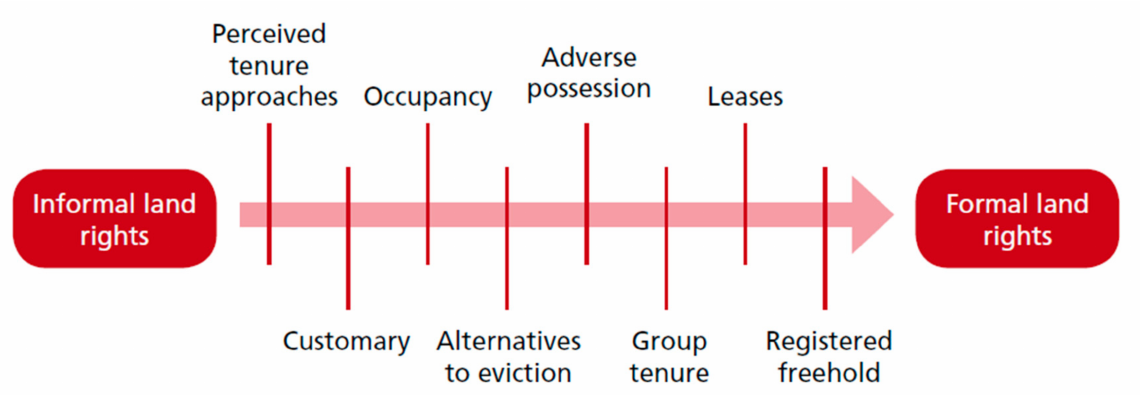
Figure 5. The continuum of land rights (Data from